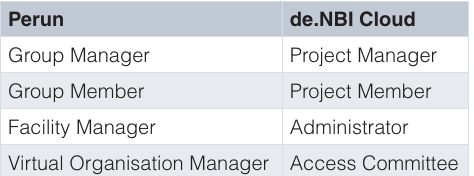
Table 1. The translation of Perun-specific roles to de.NBI Cloud-specific roles. Perun